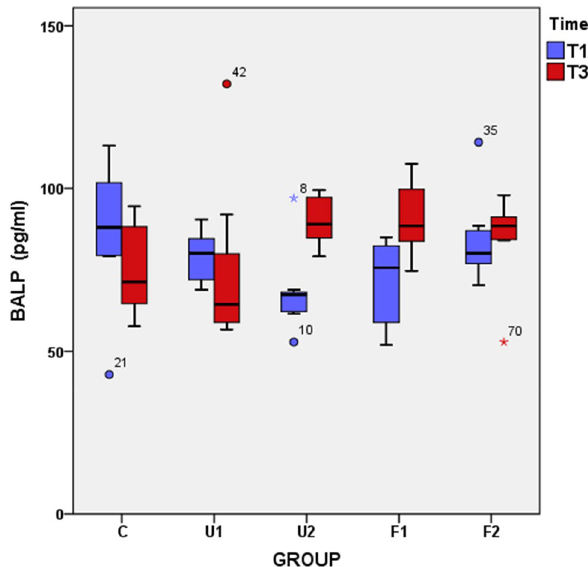
Figure 4. Graphical presentation of the changes in the serum bone-specific alkaline phosphatase (BALP) level from time T1 (day 7) to T3 (day 21) in groups.